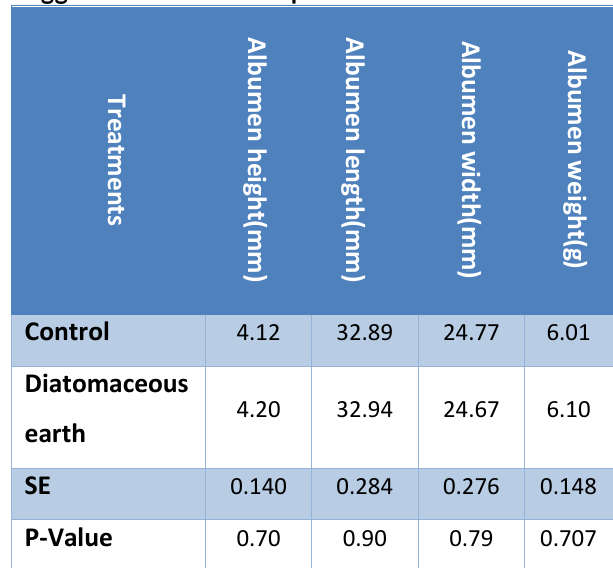
Table, 3: Evaluation of diatomaceous earth on egg characteristics in quail